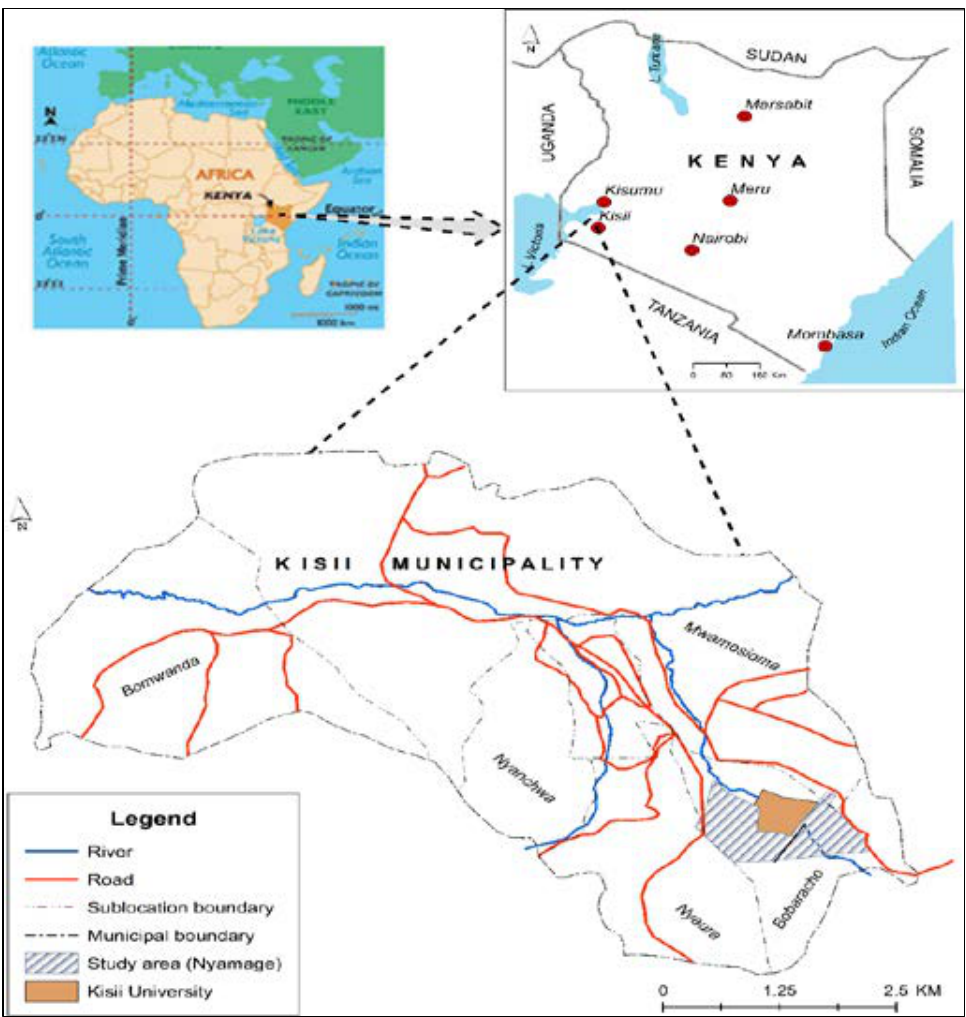
Fig. 1: Location of the study area in the national and regional Fig. 1: Geographic location of the study area in the national and regional context